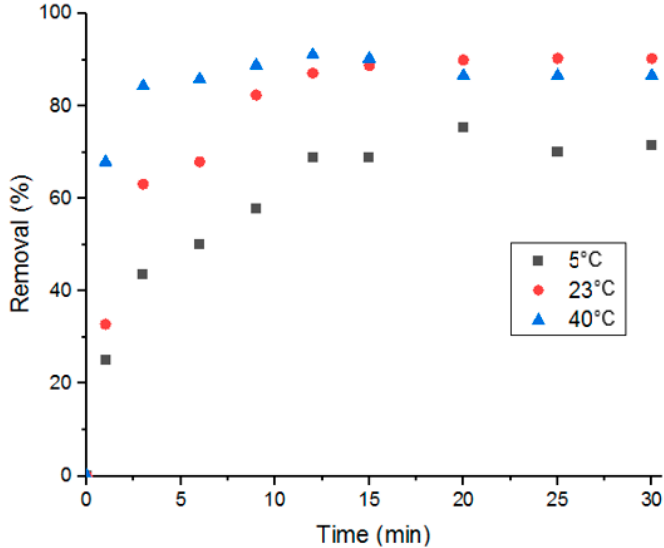
ff erent solution